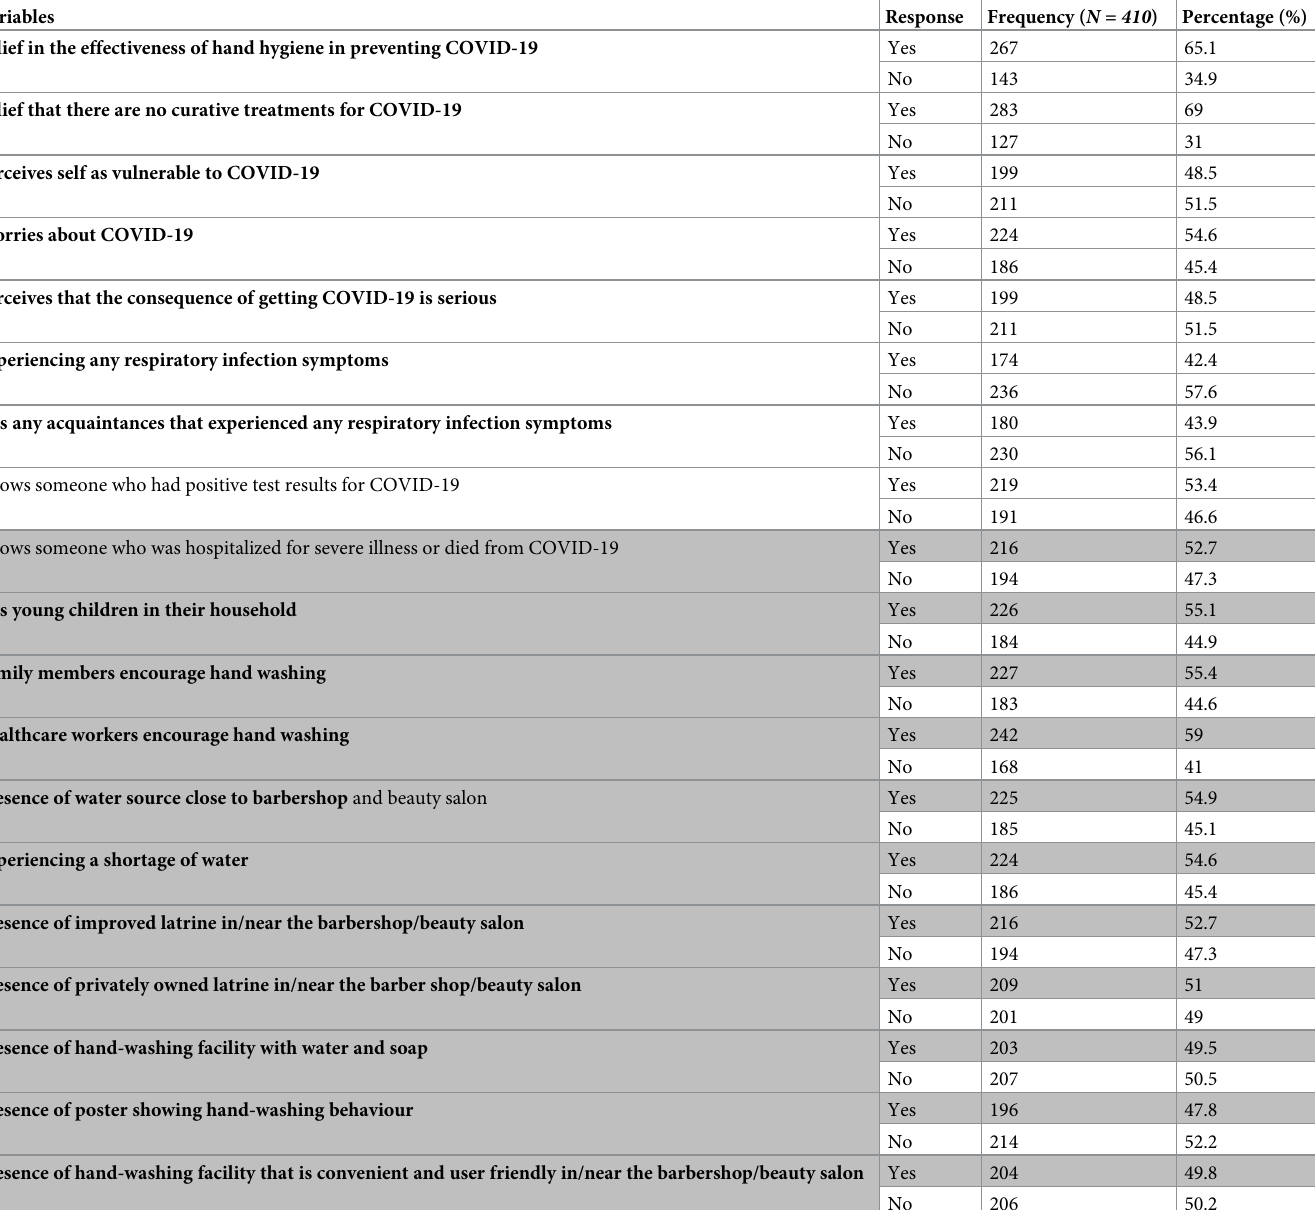
Table 2. Behavioral and environmental factors among barbers and beauty salon workers in Dessie City and Kombolcha Town, Northeastern Ethiopia, January 5 to February 10, 2021.